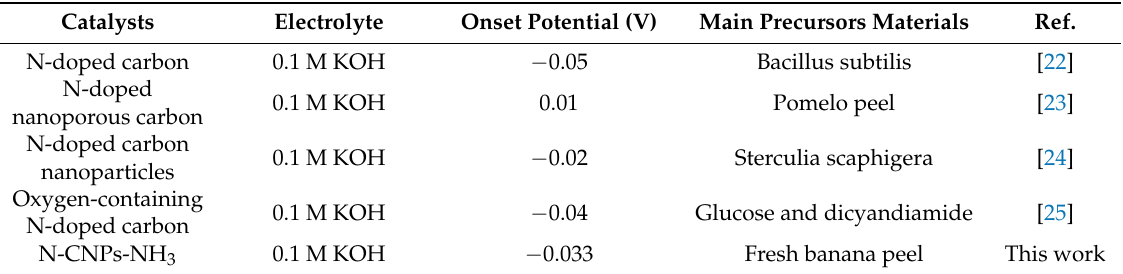
Table 3. Comparison of ORR performance of N-CNPs-NH3 with